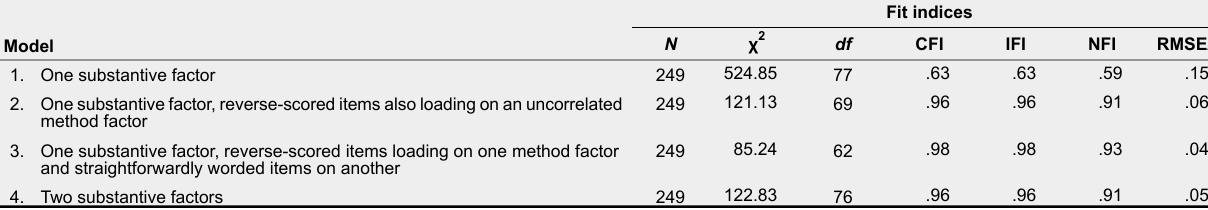
Fit Indices of Four Alternative Models of the Structure of the SCO Scale